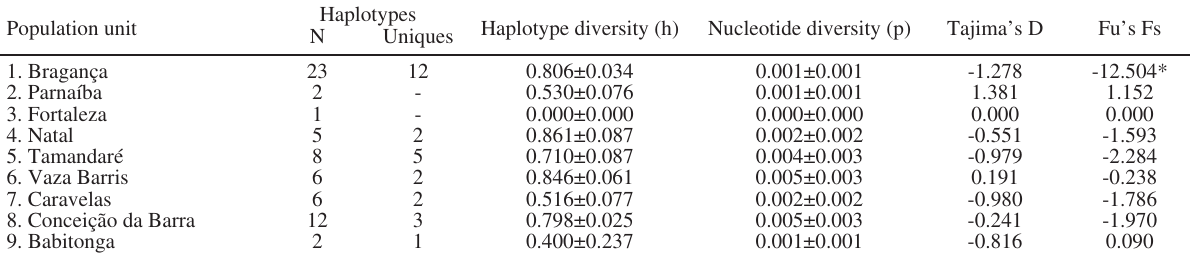
Table 3. – Pairwise F (below diagonal) and geographic distance data (above diagonal) for population units of Epinephelus itajara along coast ST of Brazil after Bonferoni correction (p=0.0056); BRA, Bragança; PAR, Parnaíba; NAT, Natal; TAM, Tamandaré; VBS, Vaza Barris; CAR,